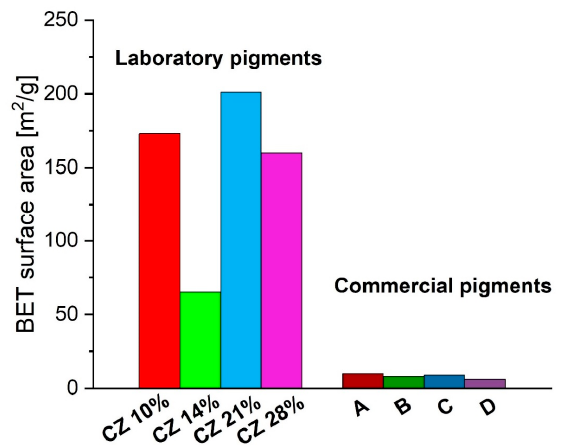
Figure 9. BET surface area of laboratory and commercial pigments.